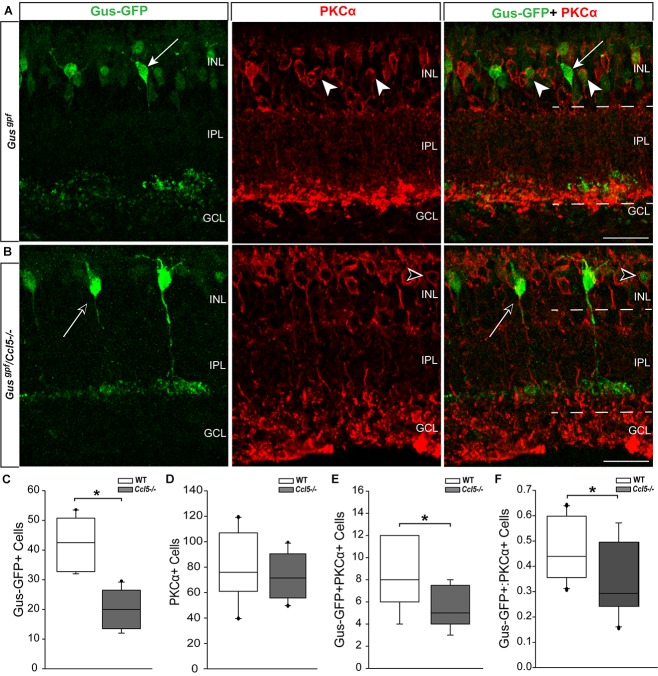
Ccl5 deficiency alters rod bipolar cell phenotypes and morphology. (A,B) Representative confocal micrographs (60×) of retina from Gusgfp mice (A) and Gusgpf/Ccl5-/- mice (B) co-immunolabeled with primary antibodies against GFP (green) and the rod bipolar cell marker PKCα (red). Scale = 20 μm. (A) GFP labels PKCα- type 7 cone bipolar cells (filled arrows) and some PKCα+ rod bipolar cells (filled arrowheads) in WT Gusgfp retina. (B) In Gusgpf/Ccl5-/-, GFP +/PKCα– cone bipolar cells (unfilled arrow) appear unremarkable. However, GFP+/PKCα+ rod bipolar cells (unfilled arrowhead) appear far less abundant. GFP–/PKCα+ rod bipolar cells appear to terminate in the GCL rather than in the IPL (dotted lines) just below GFP+/PKCα– cone bipolar cells, as seen in WT Gusgfp retina (A). (C–E) Box plots depicting the number of Gus-GFP+ (C), PKCα+ (D), and GFP+/PKCα+ (E) cells (y-axes) in the INL of Gusgfp (white) and Gusgpf/Ccl5-/- (gray) mice. Asterisks indicate p < 0.05. (F) Box plot depicting the ratio of Gus-GFP+ to PKCα+ bipolar cells (y-axis) in WT (white) and Ccl5-/- (gray) mice. Asterisks indicate p < 0.05.